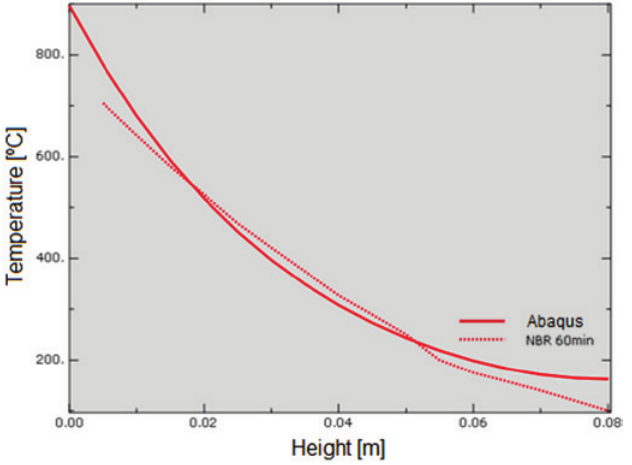
Temperature as function of the slab height, times less than 30 minutes